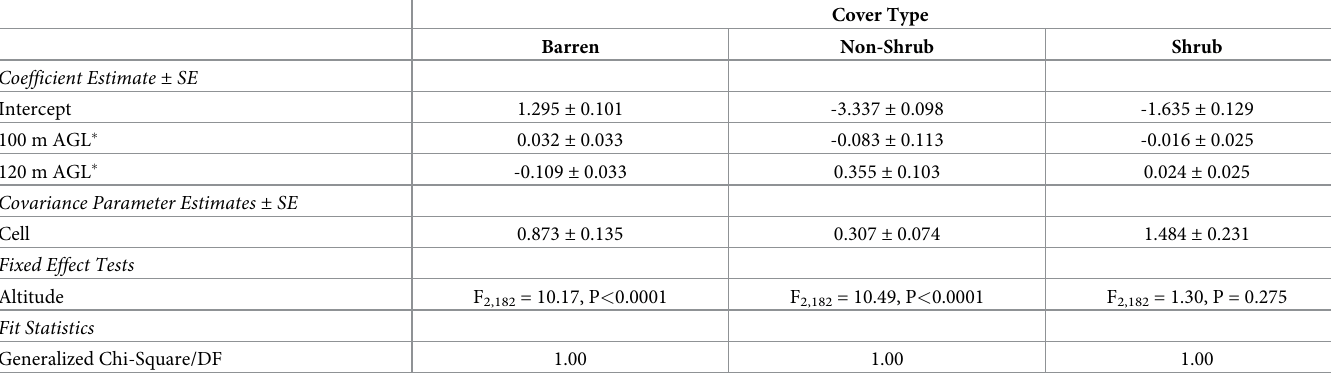
Table 3. Coefficient estimates from Beta GLMM for each cover type (barren, non-shrub, and shrub) as measured by drone transects at altitudes of 75, 100 and 120m AGL. Estimates obtained from 92 observations (cells) across 5 different study